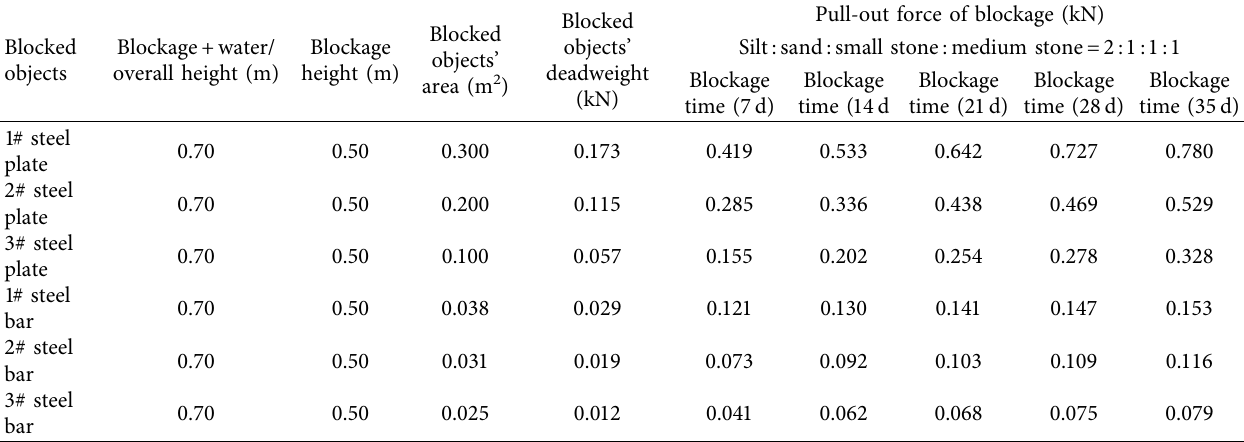
Table 8: Test results of pull-out force of underwater (mixed)